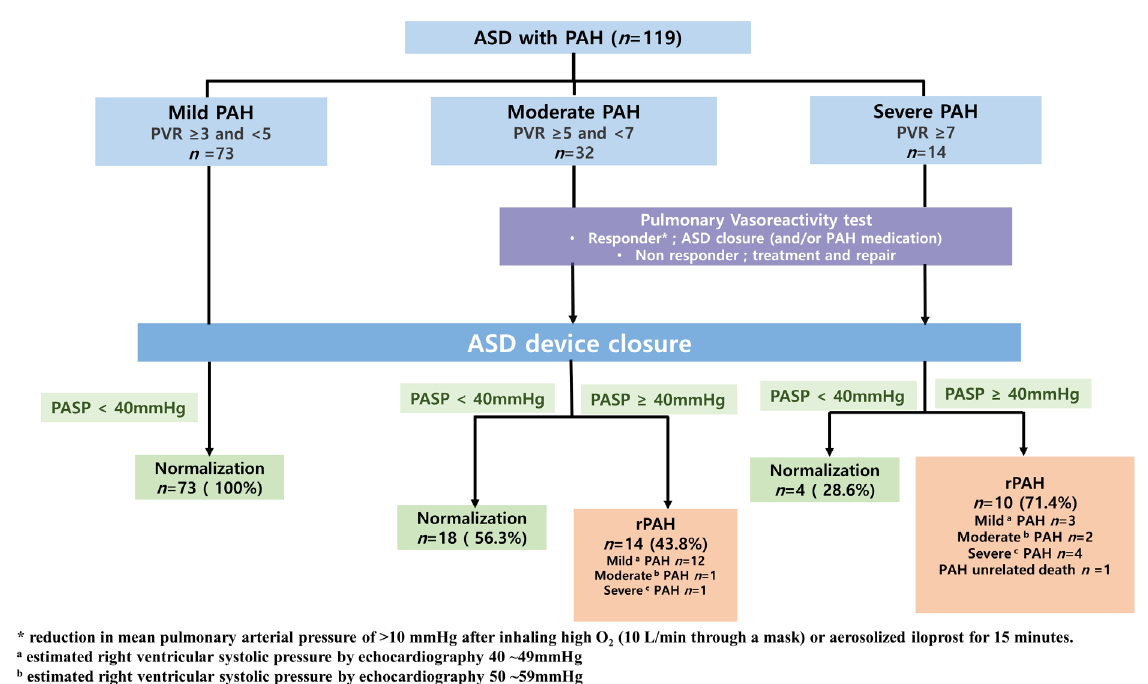
Figure 1. Flow chart of treatment and outcomes according to PAH severity in ASD patients. ASD, atrial septal defect; PAH, pulmonary arterial hypertension; PVR, pulmonary vascular resistance; PASP pulmonary atrial systolic pressure.